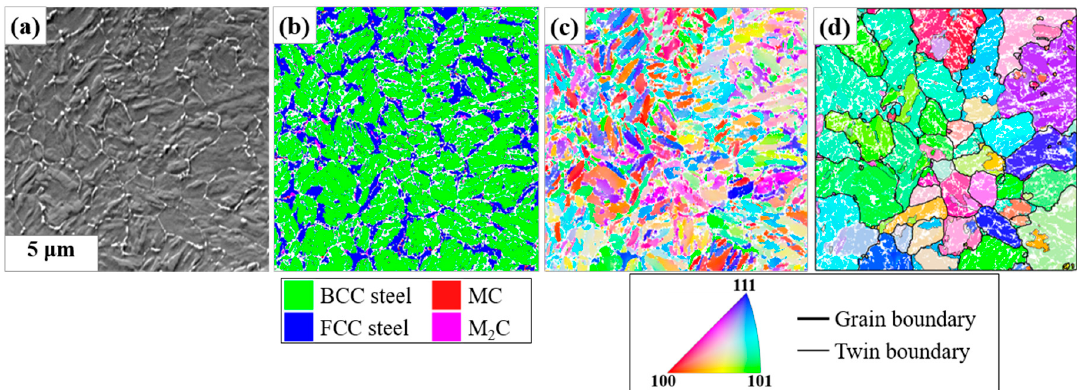
Figure 2. Microstructure of the powder: ( a ) image from forward scatter detectors (FSDs); and ( b ) phase map by the different phase colors, ( c ) original and ( d ) reconstructed inverse pole figure (IPF) map referred to the normal of the observation surface (Refer to the given color key for a cubic crystal. Grain boundaries were drawn for misorientation angle >5° and the twin boundaries were defined by the misorientaions of 60°//<111> within 5° tolerance).